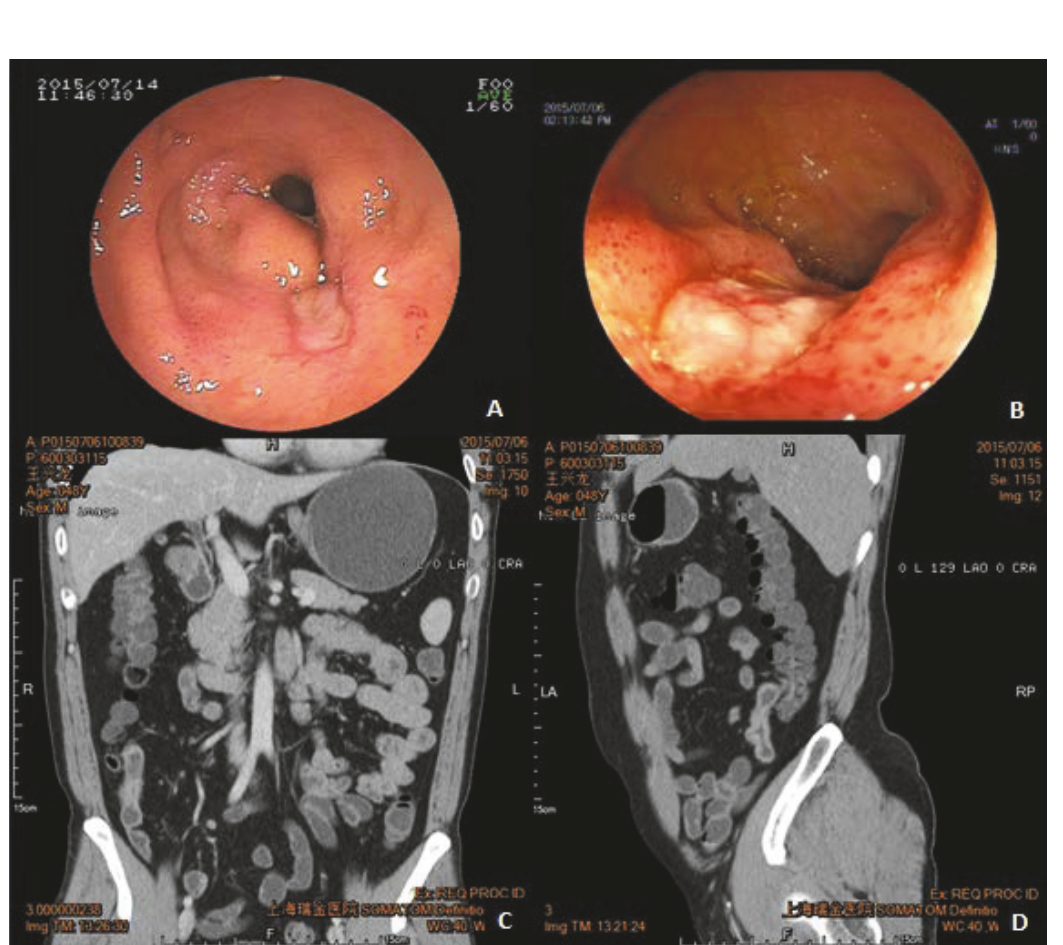
Figure 1: Endoscopic and CTE features in intestinal BD. (a, b) Colonoscopy revealed oval punch-out ulcer with discrete margin in the ileocecal region. (c, d) CTE showed the same patient with thickening bowel wall and circumintestinal exudation in the terminal